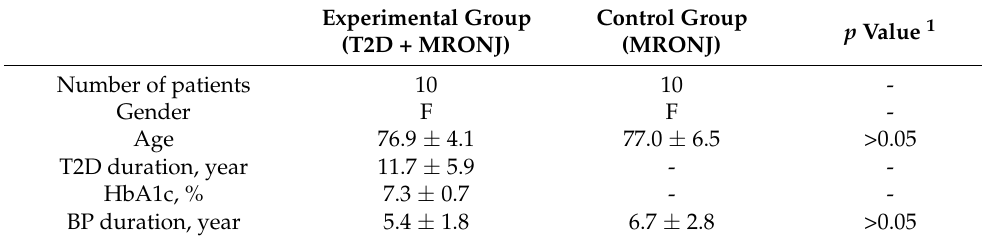
Table 1. Baseline characteristics of patients ( n = 20).